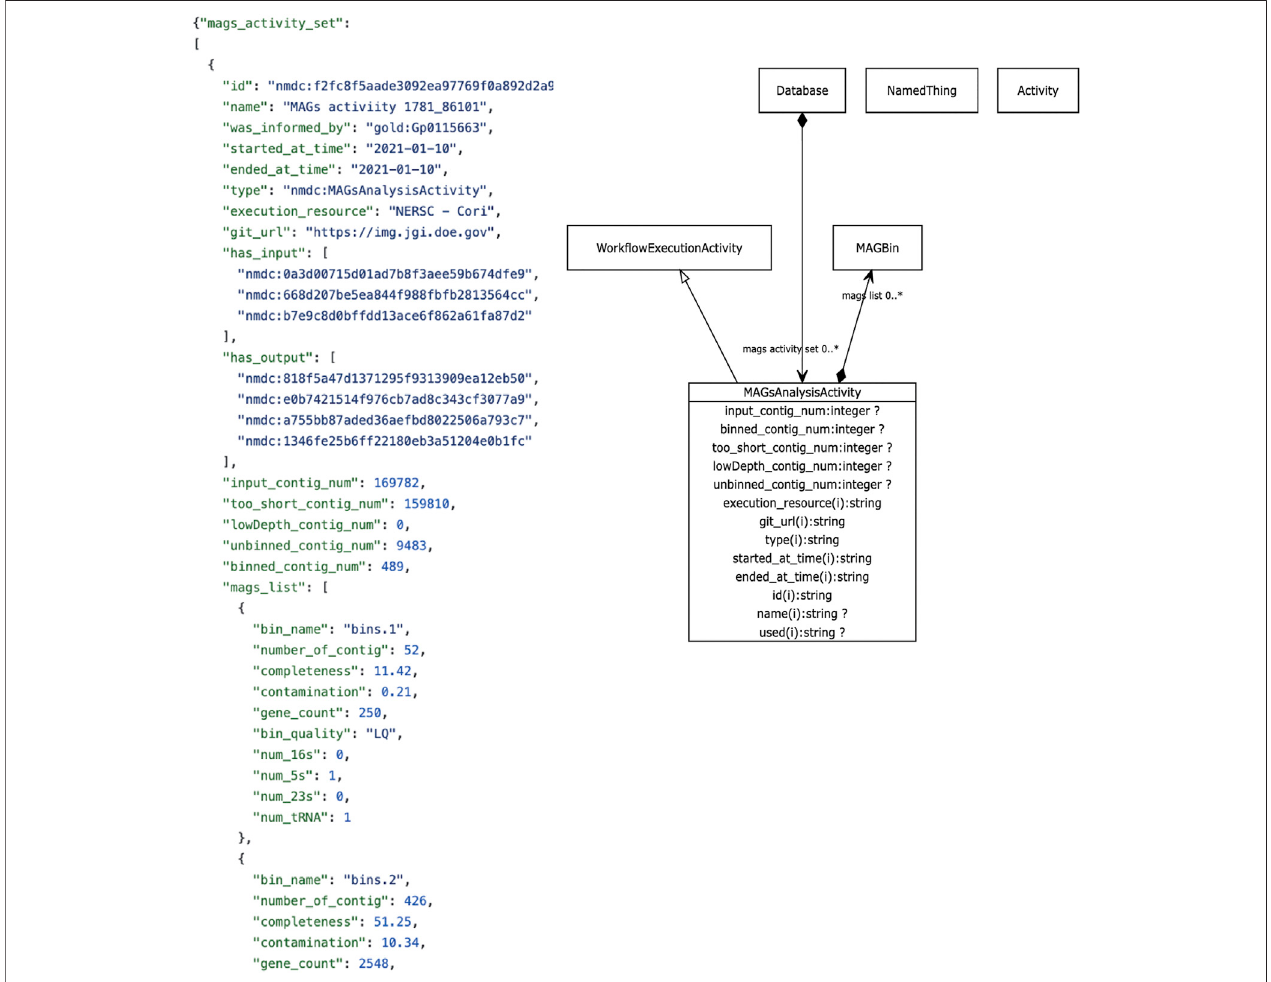
FIGURE 3 | Example NMDC work fl ow metadata. Left panel shows an example JSON output snippet of a MAGSAnalysisActivity, which is a record of the metagenomic assembled genome (MAG) work fl ow execution. It includes generic work fl ow metadata (start/end time, execution resource) and MAG-speci fi c metadata and work fl ow outputs. The full JSON example is available on-line (https://github.com/microbiomedata/nmdc-metadata/blob/master/examples/MAGs_activity.json). Right panel shows a visual depiction of the MAGSAnalysisActivity class in the NMDC LinkML schema (https://microbiomedata.github.io/nmdc-schema/